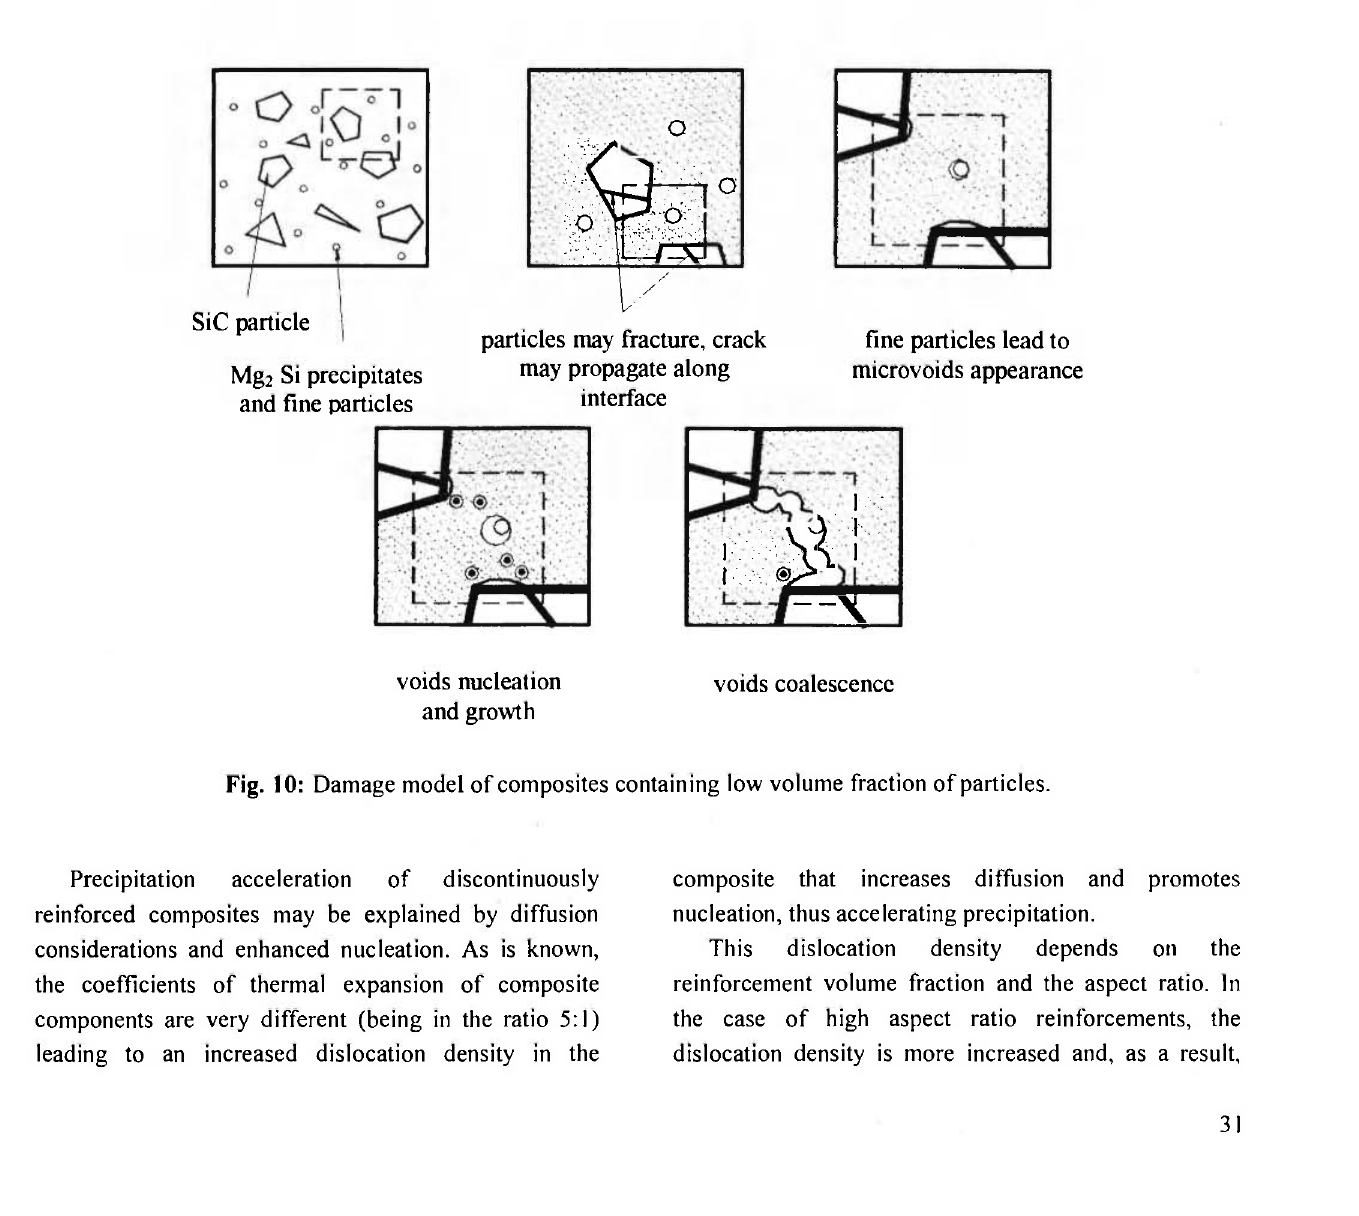
Fig. 8: Optical microstructure of as-cast 6063A1 / 5%SiC p composite.